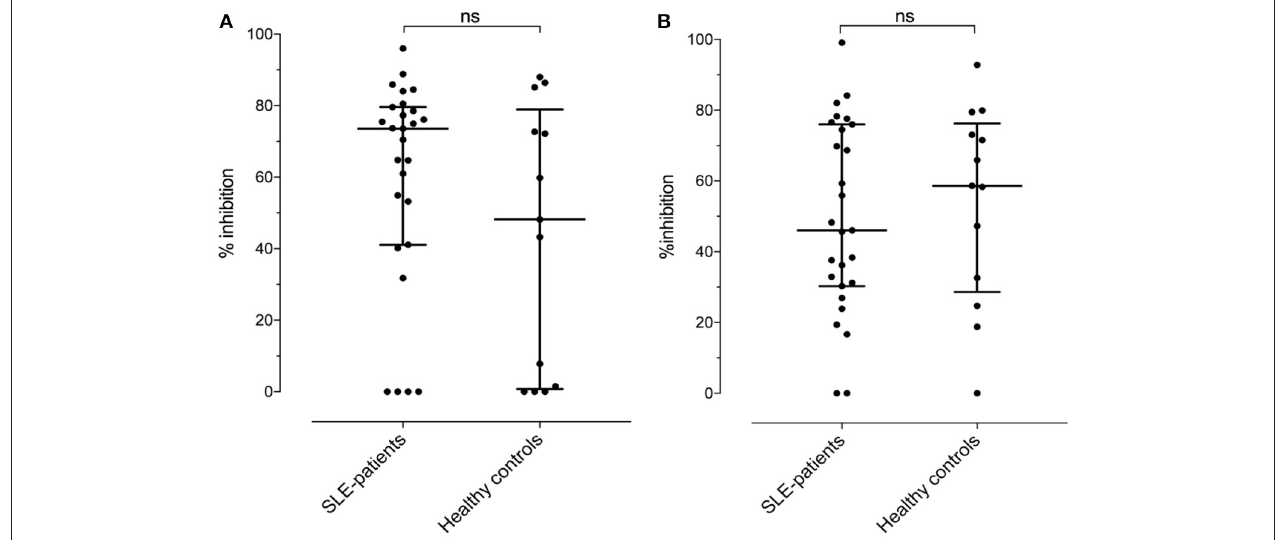
FIGURE 6 | (A) Relative inhibition (percentage) of anti-HSA IgG by the presence of an excess in fluid phase BSA [median of SLE patients: 73.6 vs. healthy controls: 48.2, not significant (Mann–Whitney)]. ( B) Relative inhibition (percentage) of anti-BSA IgG by the presence of an excess in fluid phase HSA [median of SLE patients: 46.1 vs. median of healthy controls: 58.6, not significant